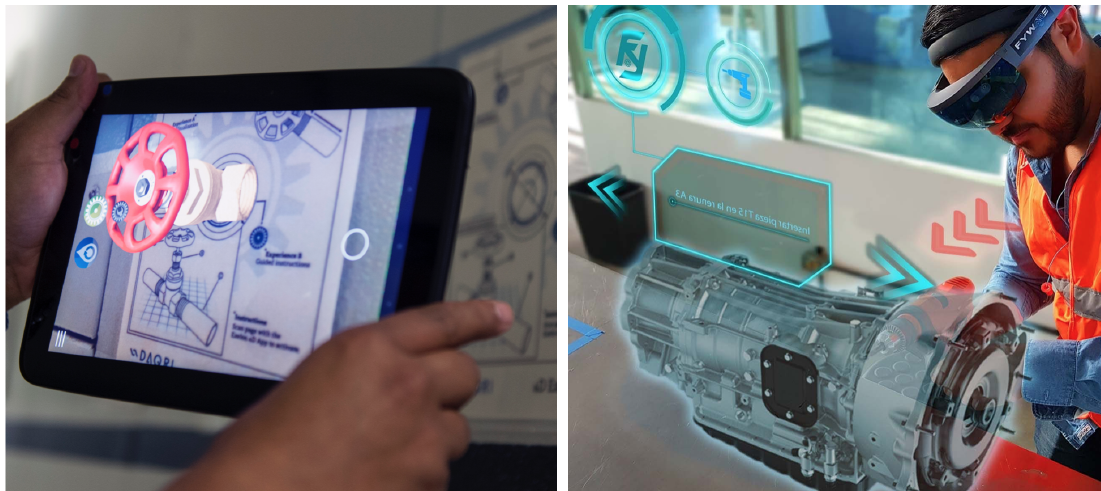
Figure 1. Examples of augmented reality (AR) applications for maintenance. Left image from Office of Naval Research, https://www.flickr.com/photos/usnavyresearch/23388133082, right image from Carlos Fy,